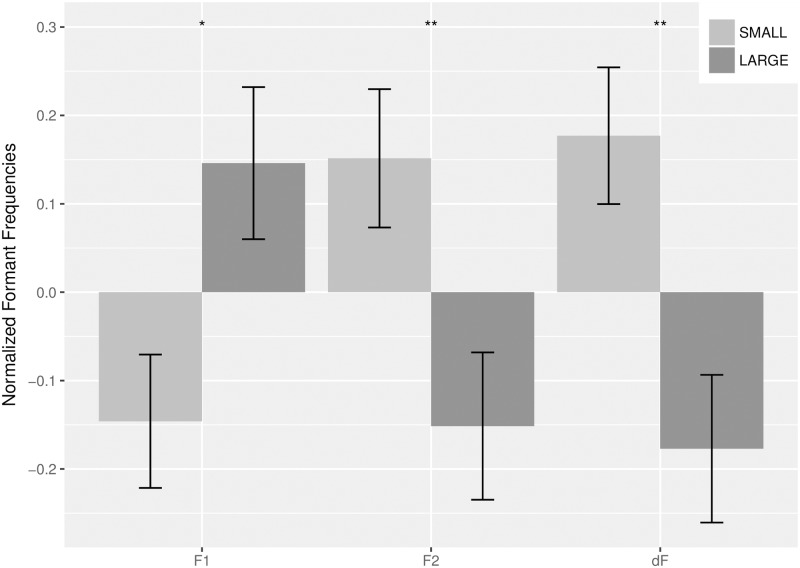
Comparison of formant frequencies for the semantic categories.Height of bars indicates normalized value of the frequency of the formant. Orientation of bars reflects their relation to the general mean for the formant. Error bars indicate standard error of mean.